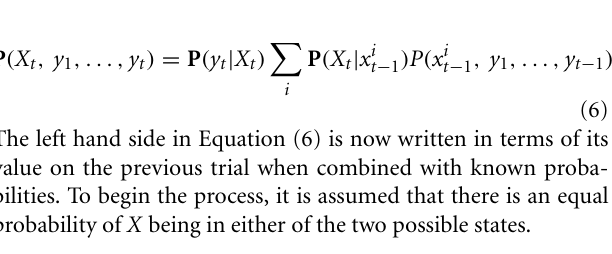
Now Equation (5) can be substituted in to Equation (3) to give